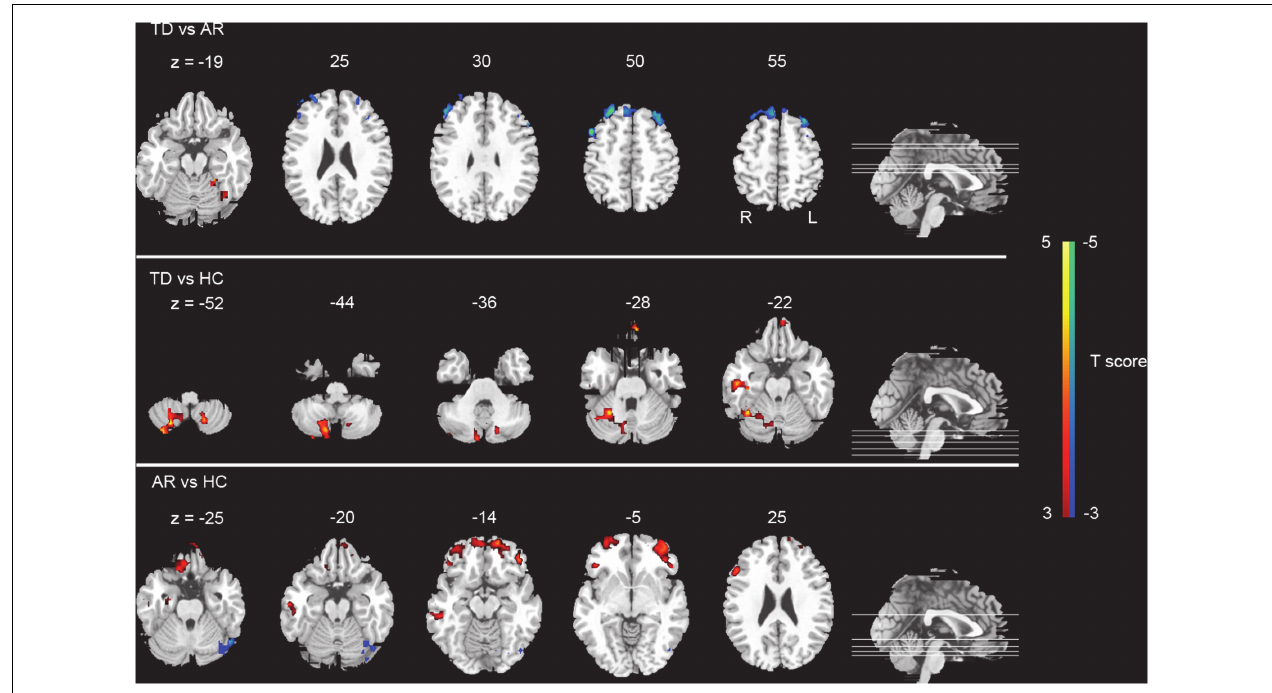
FIGURE 2 | Statistical group differences ( post hoc analyses) of FCD. The statistical differences ( t score) of post hoc analysis ( post hoc two-sample t -test, p < 0.005 corrected for multiple comparison at the cluster level, AlphSim corrected). Color bar represents the t -value.